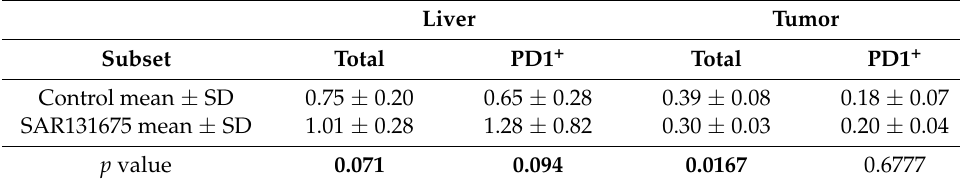
Table 2. Ratio of CD8 + to CD4 + T cell subsets in liver and tumor a